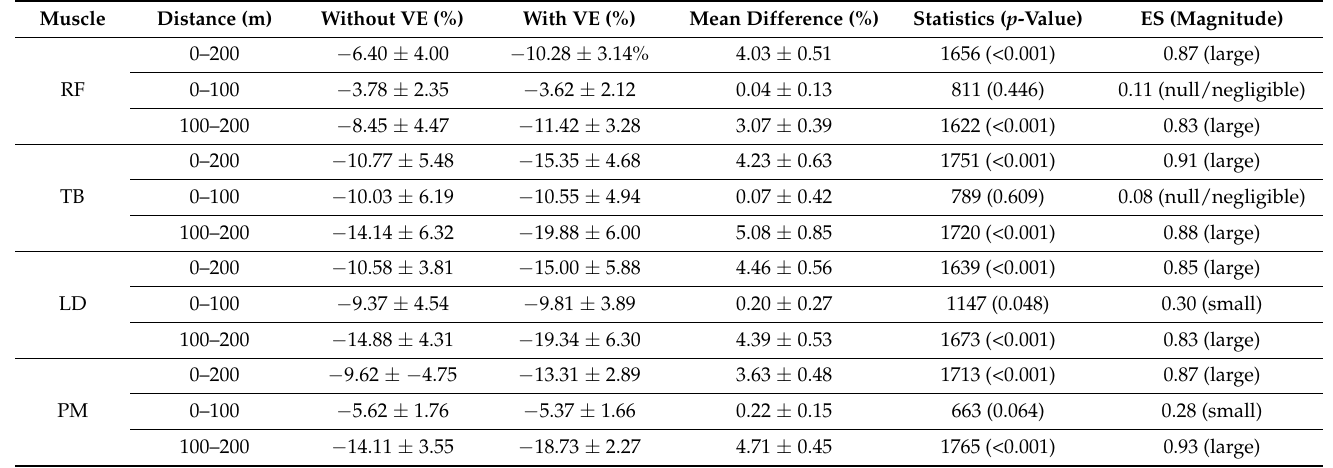
Table 4. Abbreviation: ES, effect size; LD, Latissimus Dorsi ; PM, Pectoralis Major RF, Rectus Femoris ; TB, Triceps Brachii ; VE, verbal